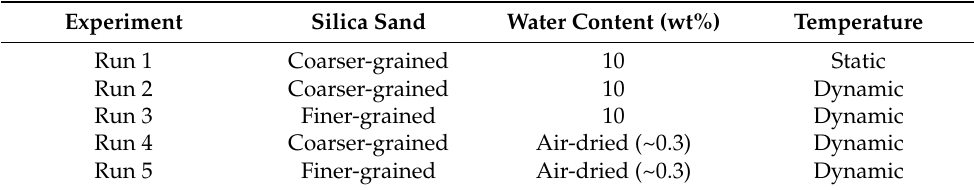
Table 1. Silica sand, water content, and temperature in each